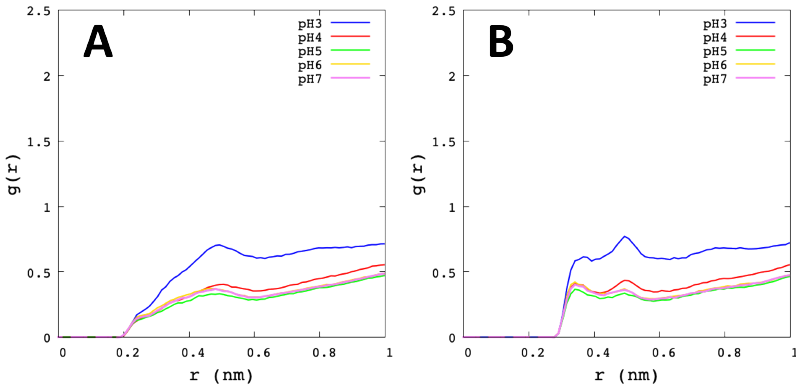
Figure 9. Radial distribution function analysis of Met49. The graphs show the average value of the Mpro protomers and the different microstates for each pH. ( A ) S δ –H ω . ( B ) S δ –O ω